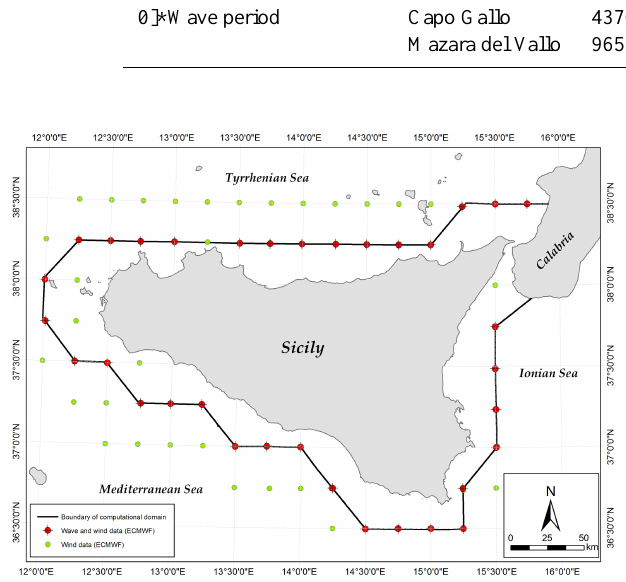
Figure 3. Localisation of the ECMWF grid points selected for the definition of the boundary